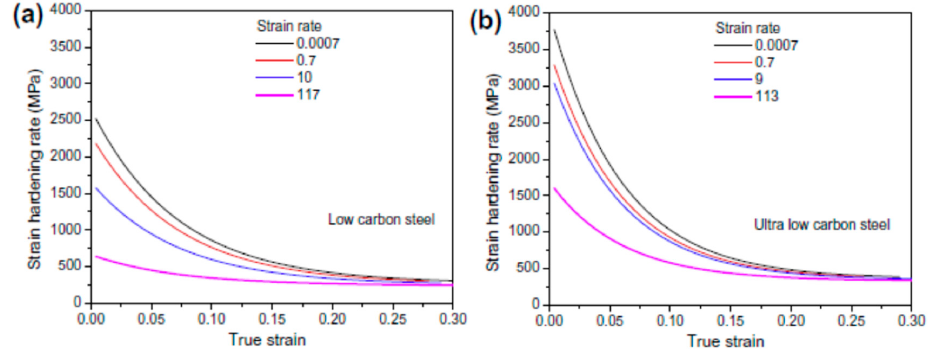
Figure 7. Strain-hardening rate at various strain rates for ( a ) low carbon steel and ( b ) ultralow carbon steel [22] .